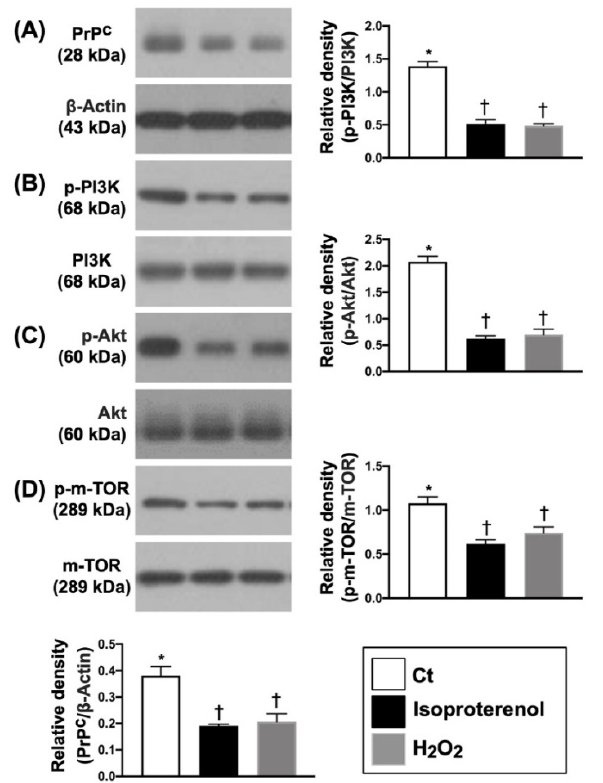
Figure 1. Isoproterenol and H 2 O 2 suppressed the PrP C and cell-stress signaling pathway in H9C2 cells. ( A ) Protein expression of cellular prion protein (PrP C ), * vs. †, p < 0.01. ( B ) Protein expression of phosphorylated (p)-PI3K, * vs. †, p < 0.001. ( C ) Protein expression of p-Akt, * vs. †, p < 0.0001. ( D ) Protein expression of p-m-TOR, * vs. †, p < 0.001. n = 3 in each group. H 2 O 2 = hydrogen peroxide; PI3K = Phosphoinositide 3-kinase; m-TOR = mammalian target of rapamycin (m-TOR); RAC(Rho family)-alpha serine/threonine-protein